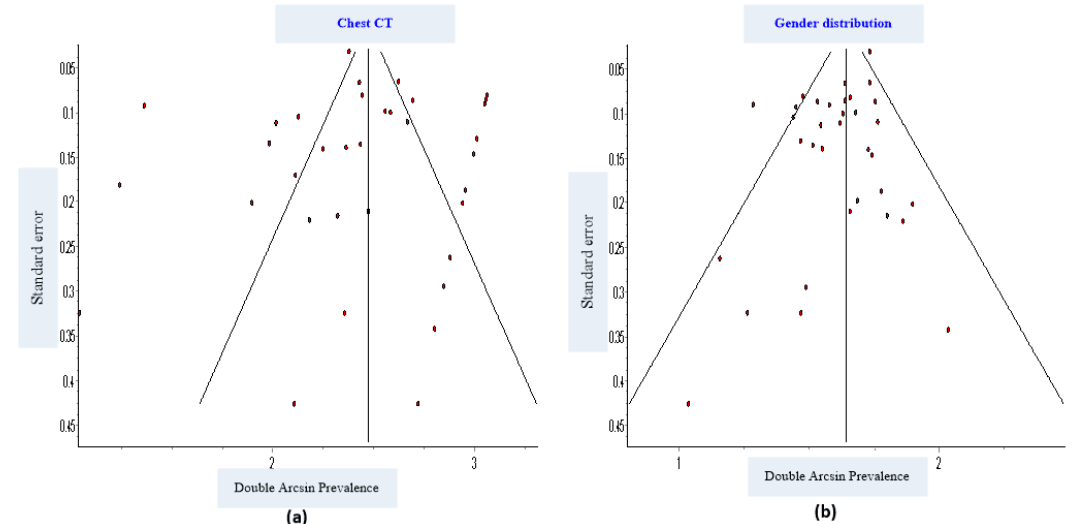
Figure A3. Funnel plots; the likelihood of publication bias was low for studies on ( a ) chest Computed tomography (CT) scans ( b ) Gender distribution (male and female).